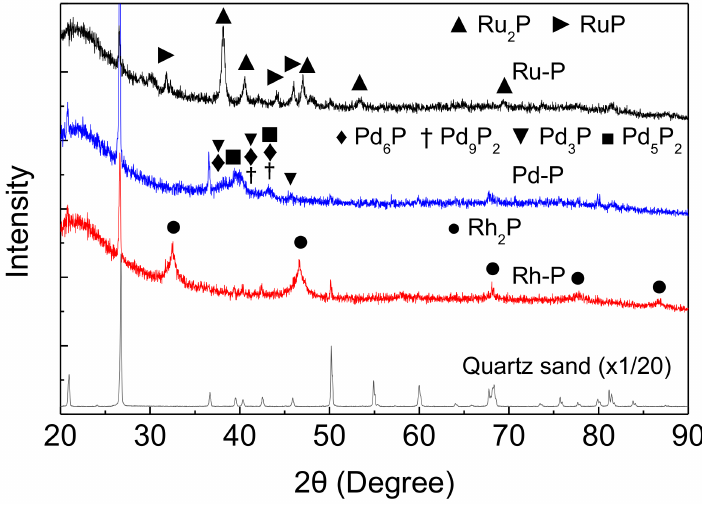
Figure 3. XRD patterns of NM-P catalysts after the HDS of DBT at 270 ◦